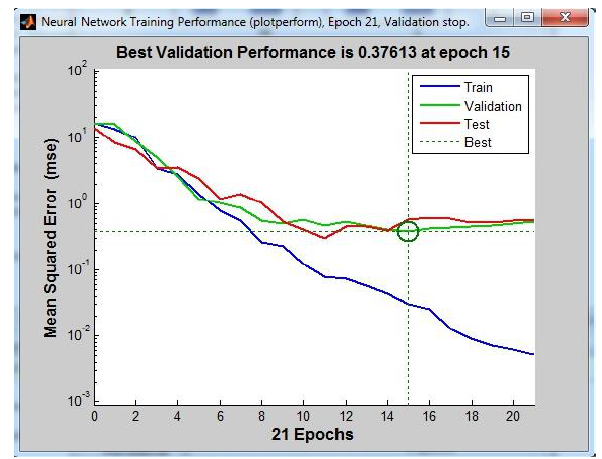
Figure 3. Related figure for learning model No. 2 and validation of model.